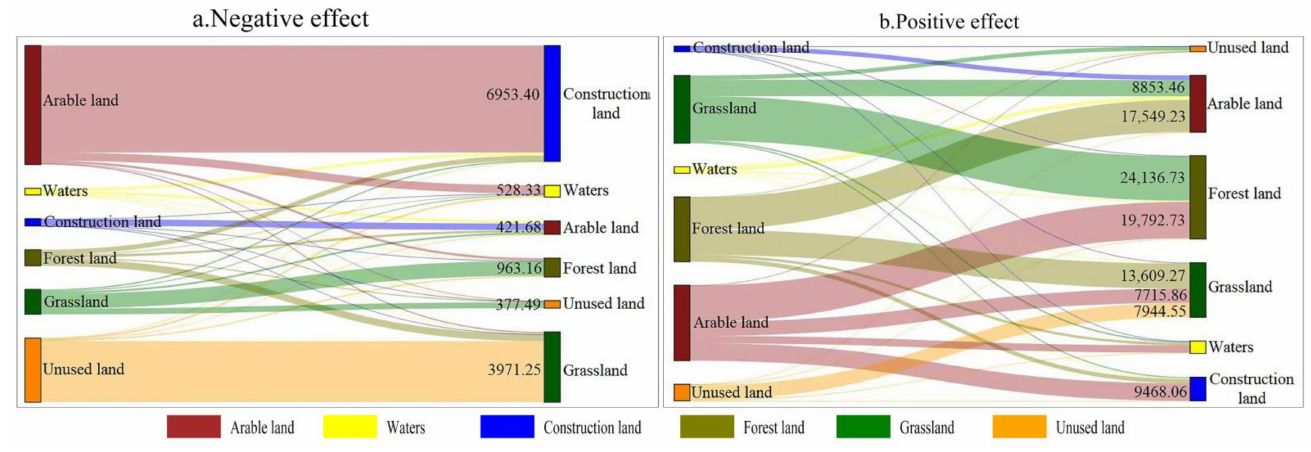
Figure 13. Land use transfer matrix of residual positive and negative effects in the Yangtze River Basin from 2000 to 2018.